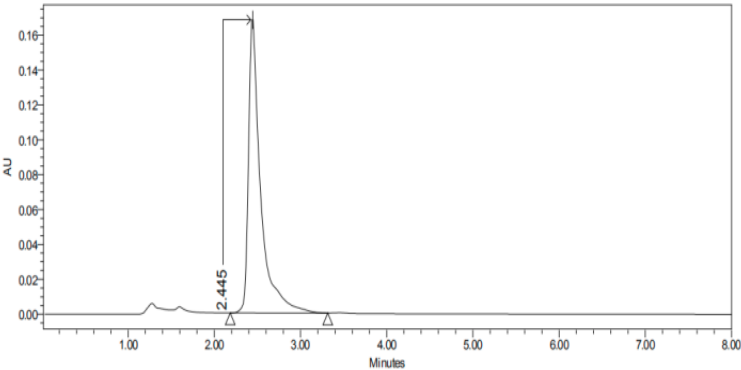
Figure 3. Chromatogram of CP-NPs in cornea at 6 h.